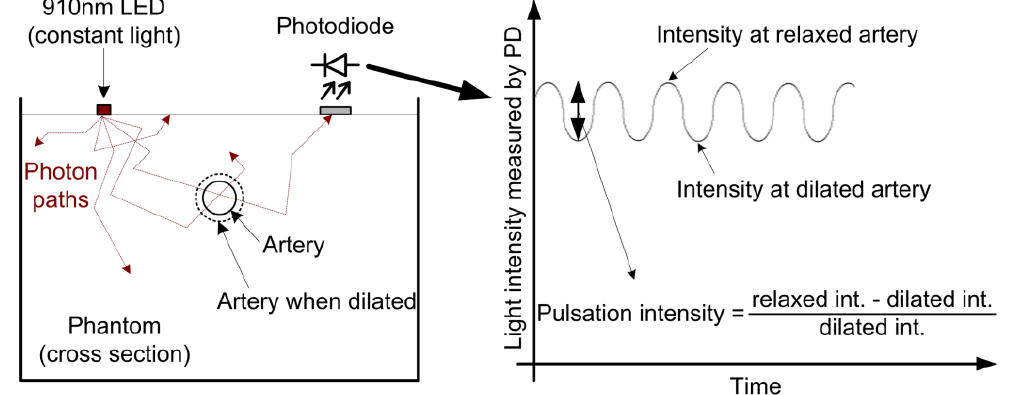
Figure 3. Photodiode signal sensing in an oscillating ( i.e. , dilating and contracting) artery. An artery in the phantom is dilating and contracting due to the pulse waves generated by the pump. The volume change in the artery causes intensity change in the light passing through. This slight oscillation can be observed in the measured photodiode current (right side of the figure). Pulsation intensity refers to the strength of the